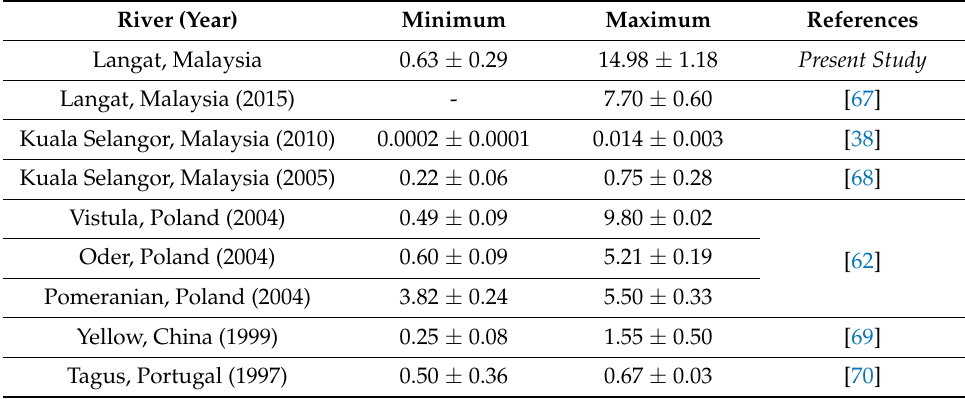
Table 6. Activity of Po-210 (mBq/L) both in Malaysian and various rivers of the world.